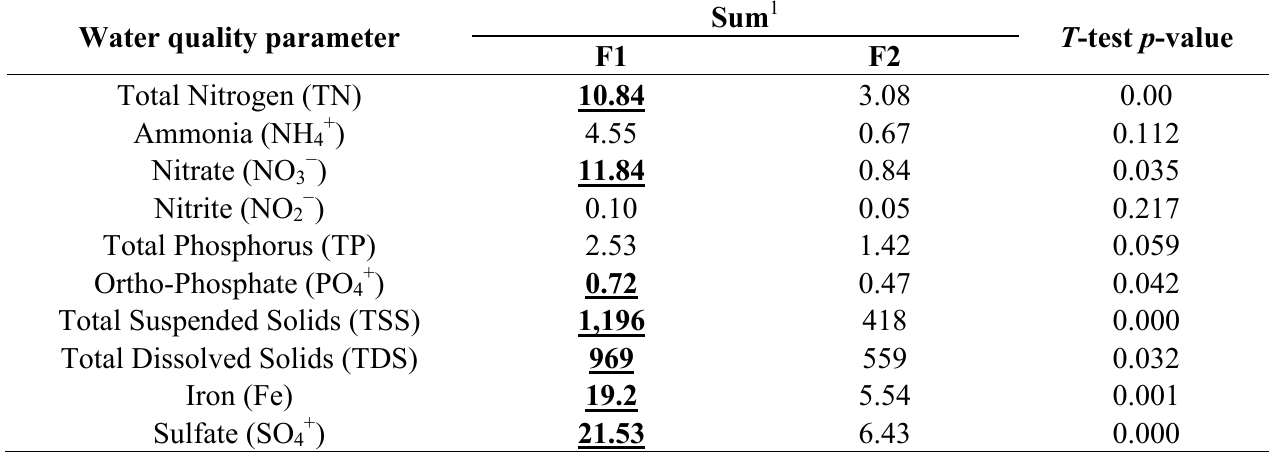
Table 2. Total values for mass losses (kg ha − 1 ) for water quality parameters measured below two natural gas well sites (F1 and F2) from October 2008–March 2010 at the Alto Experimental Watersheds in East Texas,